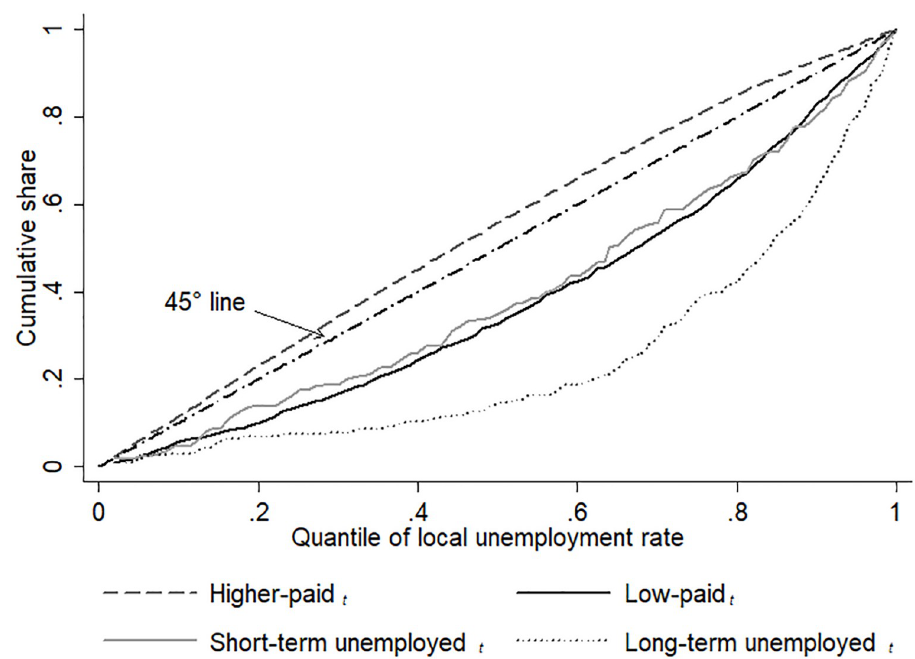
Fig 2. Distribution of labour market positions in t . Source : Understanding Society (2015), Waves 1–5, 2009–2014; linked with DfT Accessibility Statistics 2013.